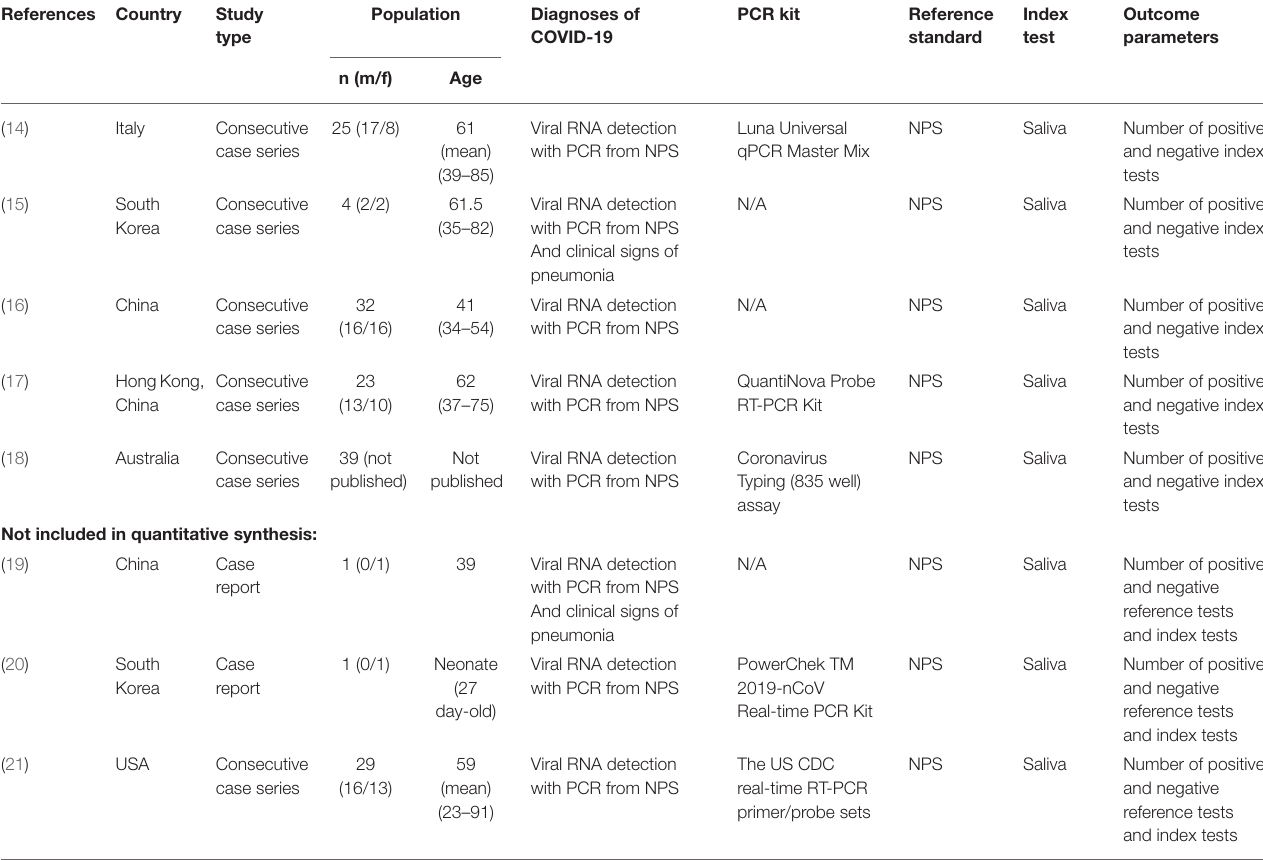
TABLE 1 | Summary of study characteristics of included